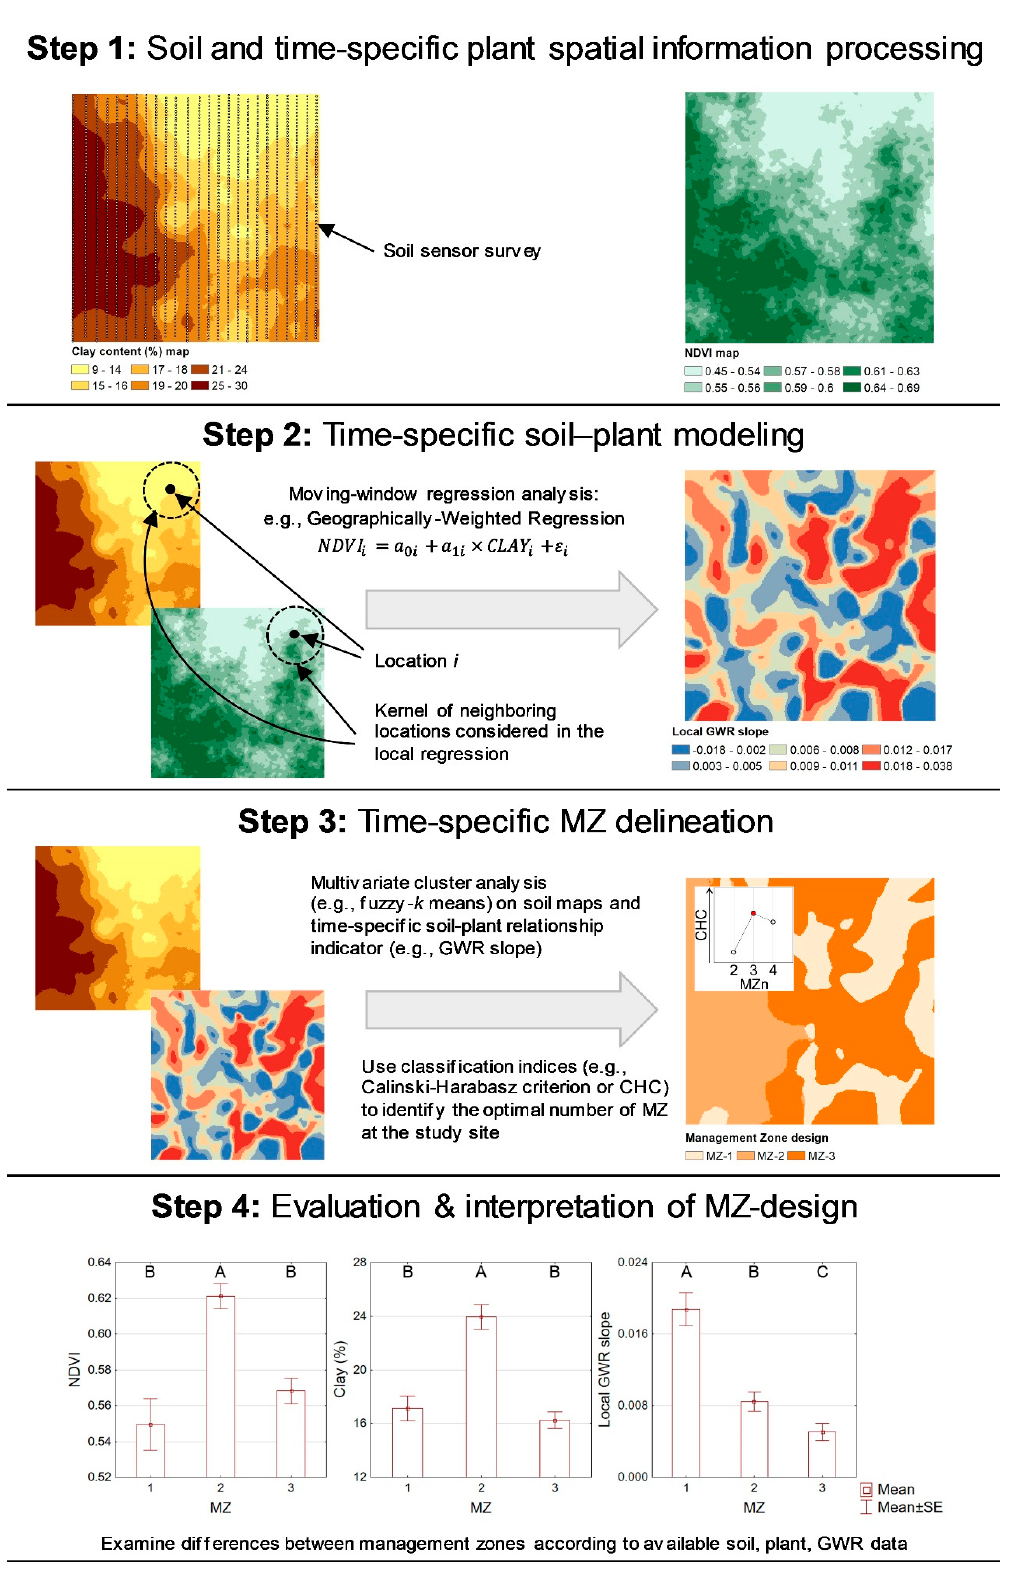
Figure 2. Diagram outlining the proposed analytical protocol to delineate time-specific management zones (MZs) from soil and (in-season) crop information. In Step 3, MZn refers to the number of considered management zones.